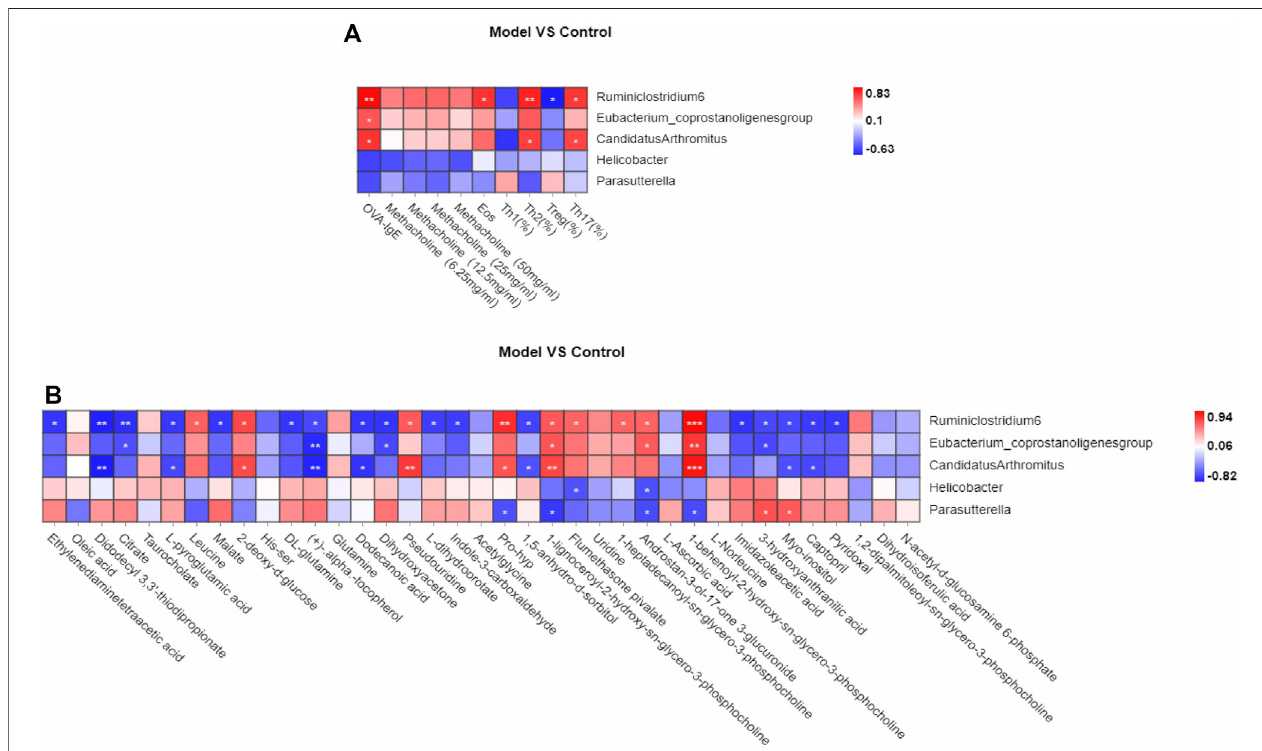
FIGURE 7 | Correlation analysis of Th1, Th2, Treg, Th17 cells, differential metabolites biomarker respectively with gut microbiota biomarkers in OVA induced eosinophilic asthma model. (A) Correlation analysis between gut microbiota biomarker and the key immune indicators of eosinophilic asthma including OVA-IgE, Penh value and eosinophil number in BALF, Th1, Th2, Treg and Th17 cells (B) Biomarkers of metabolic biomarkers associated with gut microbiota biomarkers in eosinophilic asthma mice model. * p < 0.05, ** p < 0.01, *** p ≤ 0.001. n = 7 animals per